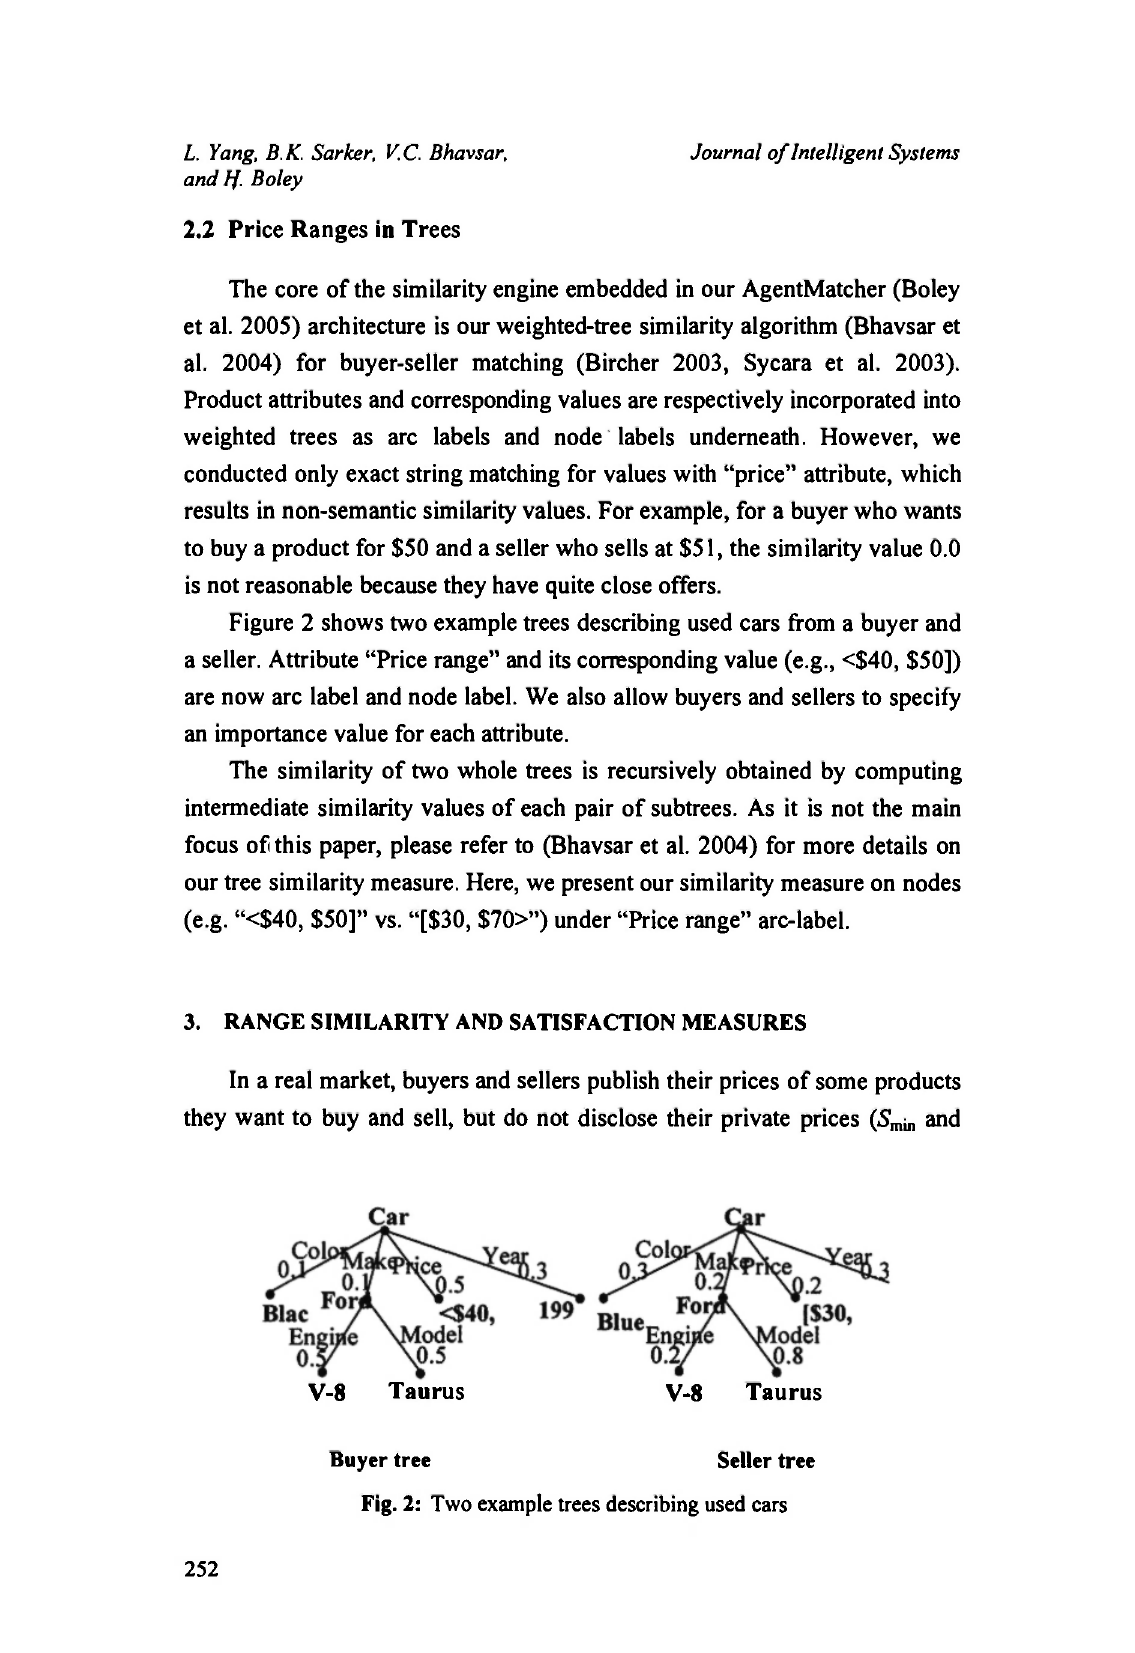
Fig. 2: Two example trees describing used